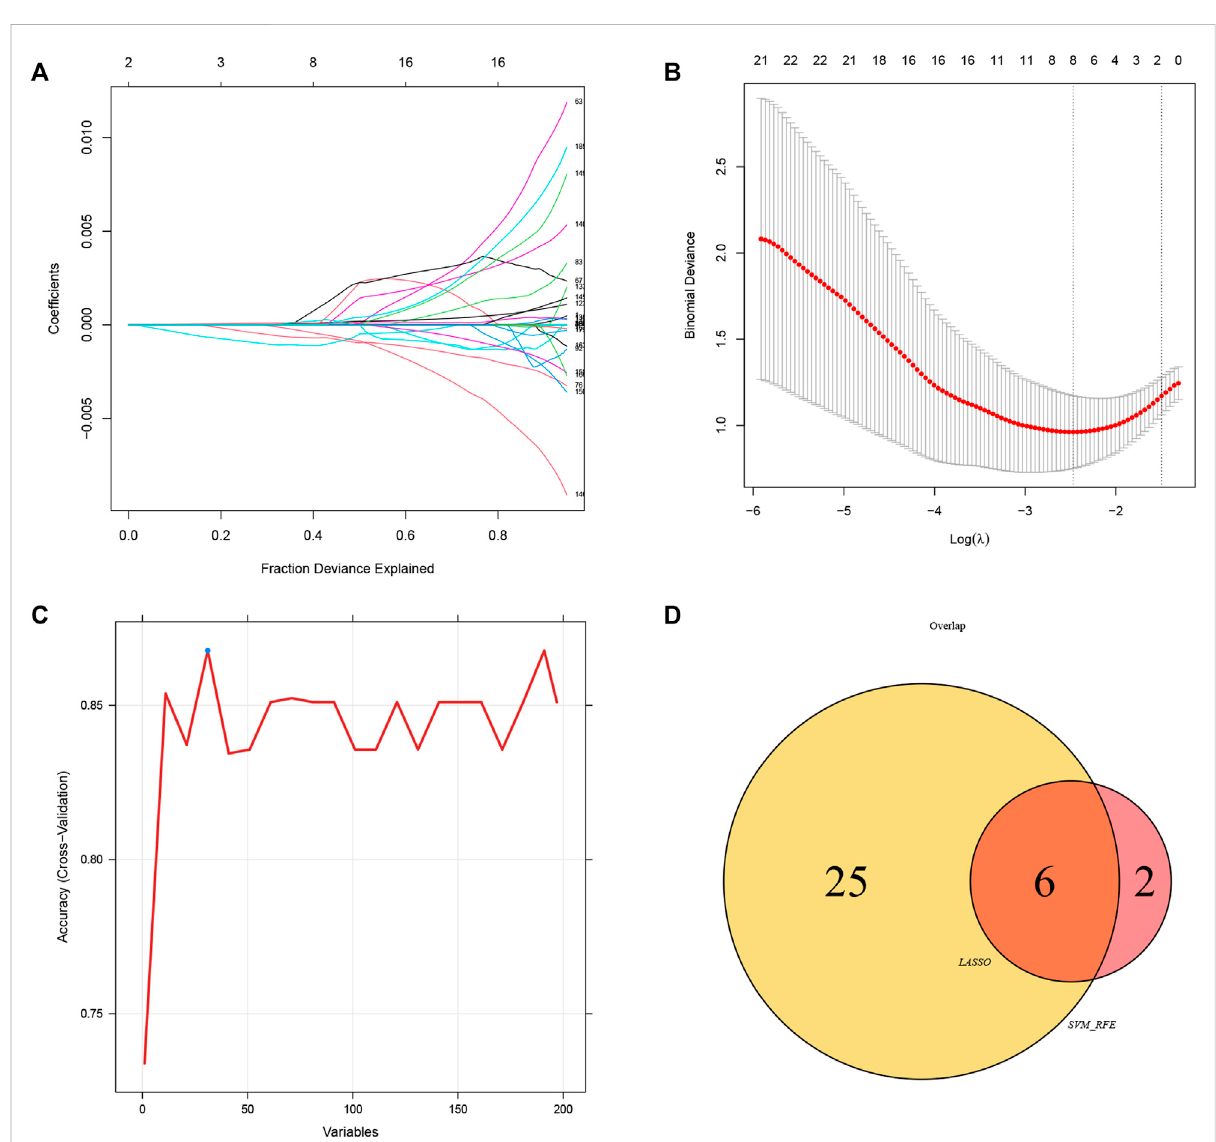
FIGURE 6 Identi fi cationofdiagnosticbiomarkers via comprehensive strategy. (A,B) Identi fi cationofbiomarkersusingtheLASSO regressionalgorithm. (C) Based on the SVM-RFE algorithm to screen biomarkers. (D) Venn diagram demonstratesix markersobtained by theLASSO regression algorithm and